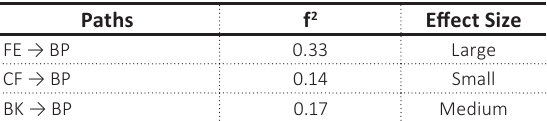
Table 6. Effect sizes ( f 2 )